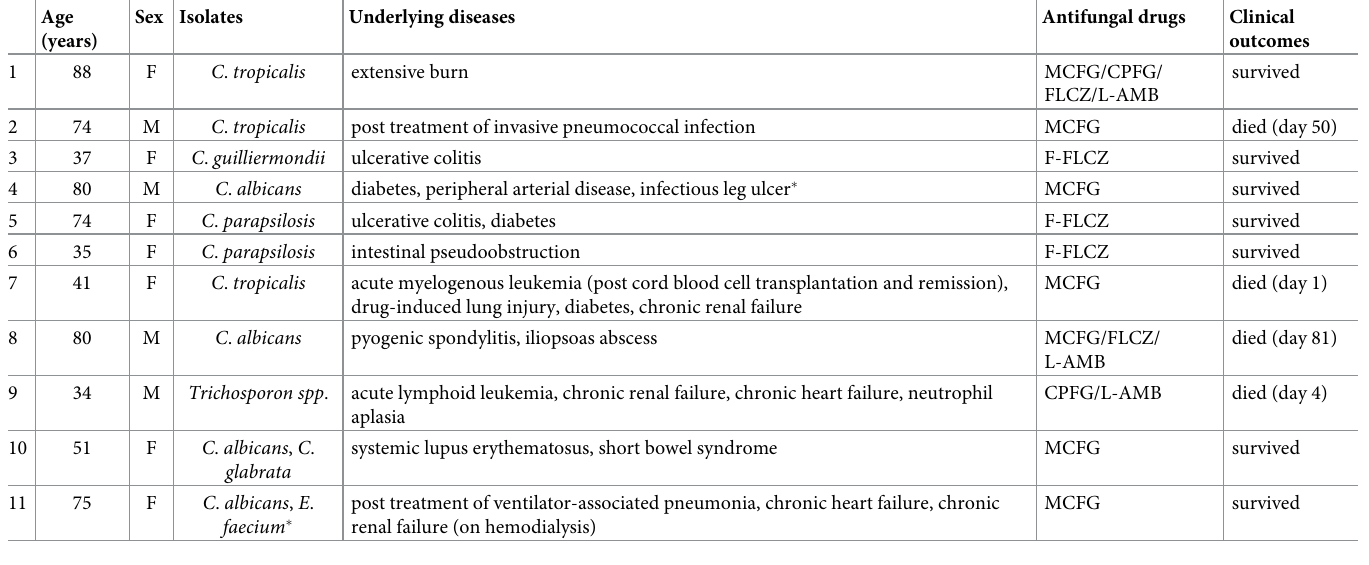
Table 1. Background characteristics of 11 patients with fungal bloodstream